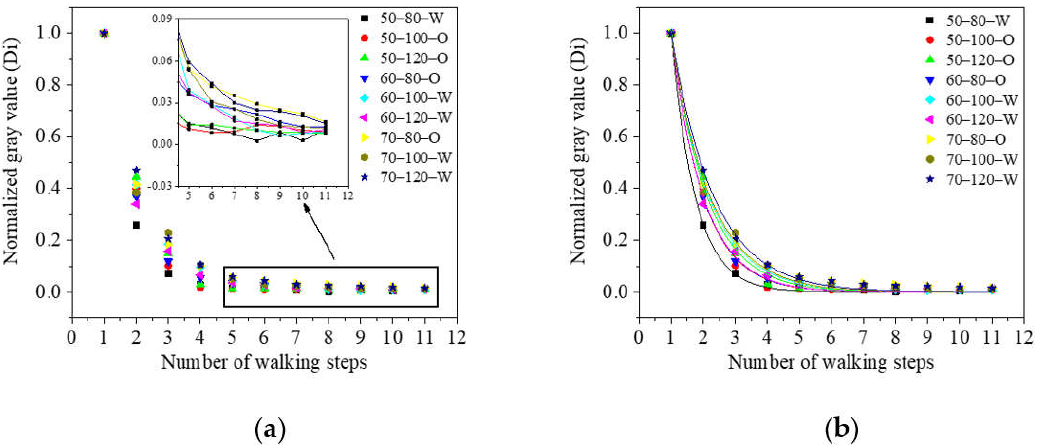
Figure 6. ( a ) Normalized gray value of the fluorescent solution with the number of walking steps. ( b ) Exponential fitting plot of the normalized gray values (50, 60, and 70 represent the weight of 50–55 kg, 60–65 kg, and 70–75 kg, respectively; 80, 100, and 120 represent the walking frequency; W: aqueous solution, O: soybean oil solution.). Table 3. Exponential fitting parameters.